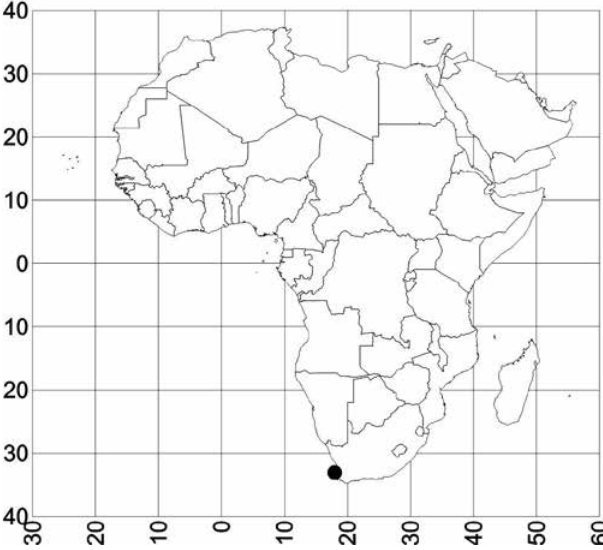
Map 2 . The distribution of B. aspera